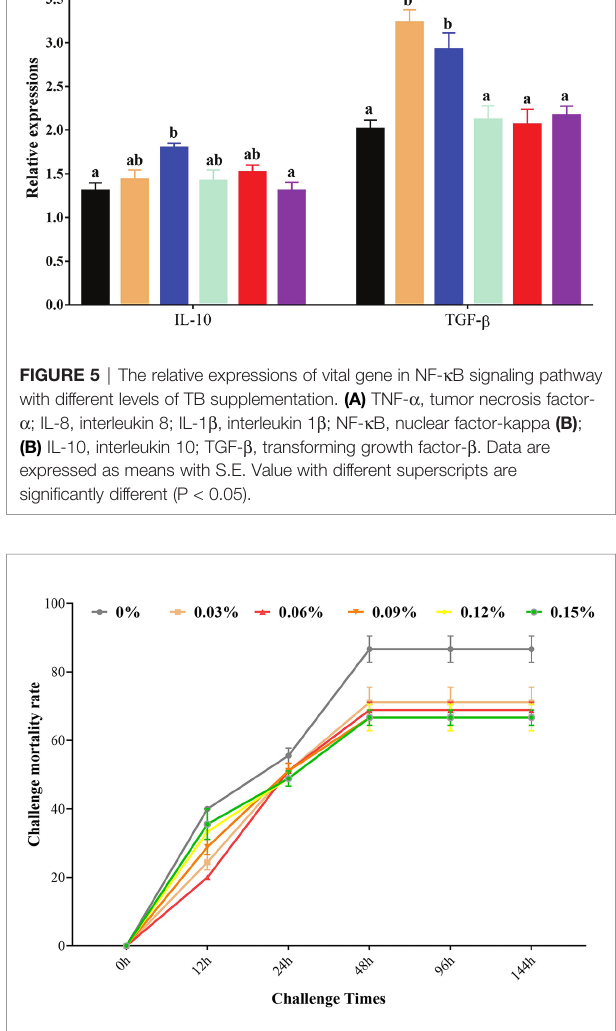
FIGURE 6 | Mortality rate with Aeromonas hydrophila challenge after during 144h with different levels of TB supplementation. Data are expressed as means with